Question: Provide a one-line summary of what is displayed.
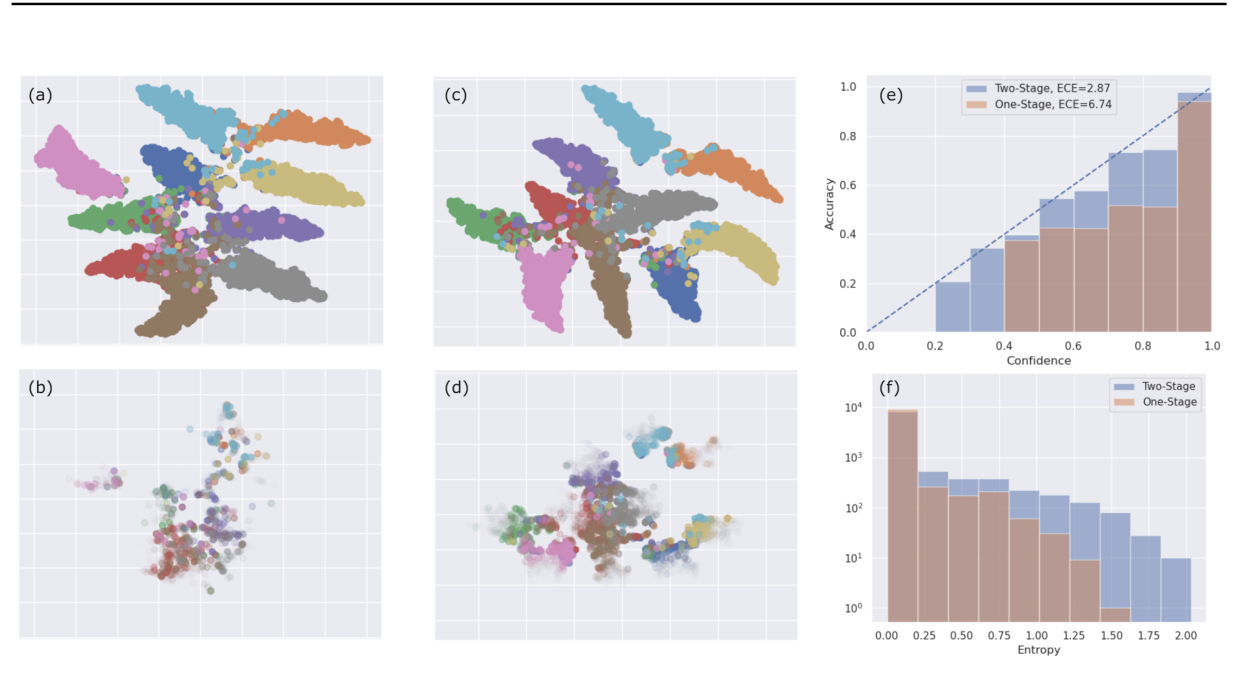
Answer: Last hidden layer outputs 2D t-SNE plots of test points from a WRN trained in one stage (left column), and two stages (center column) on CIFAR10 with accuracy 91.41% and 91.61% respectively. In the top row of t-SNE plots, (a) and (c), we plot all test points with equal color intensity, whilst in the second row, (b) and (d), higher color intensity indicates higher entropy of the prediction for a given point. Colors indicate which class the point truly belongs to. In (e) we show a calibration plot for the two models, and in (f) we show a histogram over the entropies of the predictions made by each model on the test set.